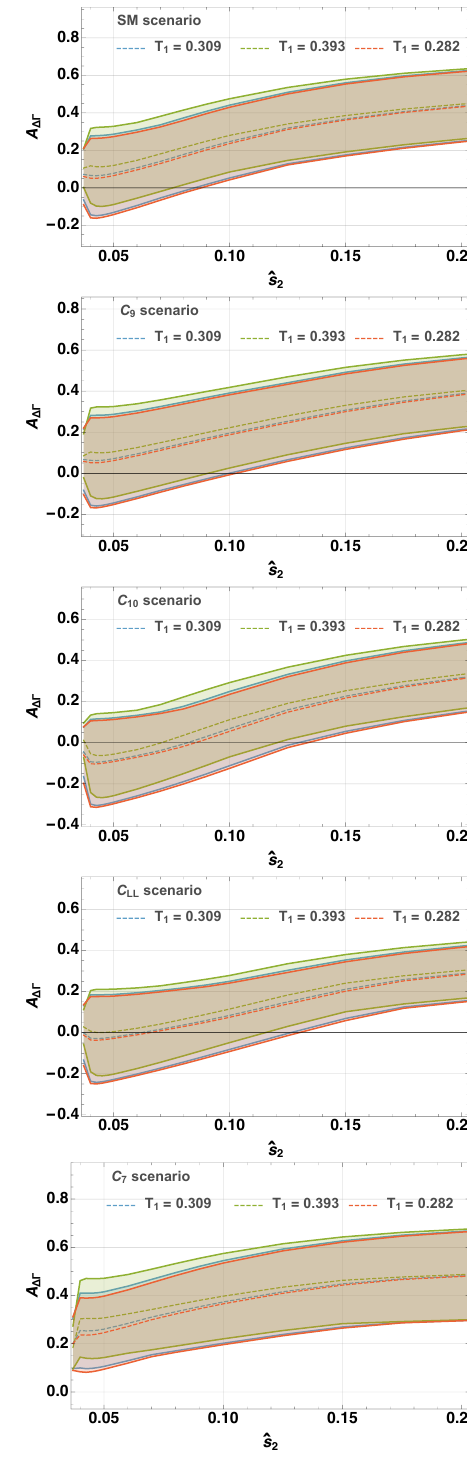
, s 1 ] (left panels) or [ s 2 , 6 GeV 2 ] (right µ